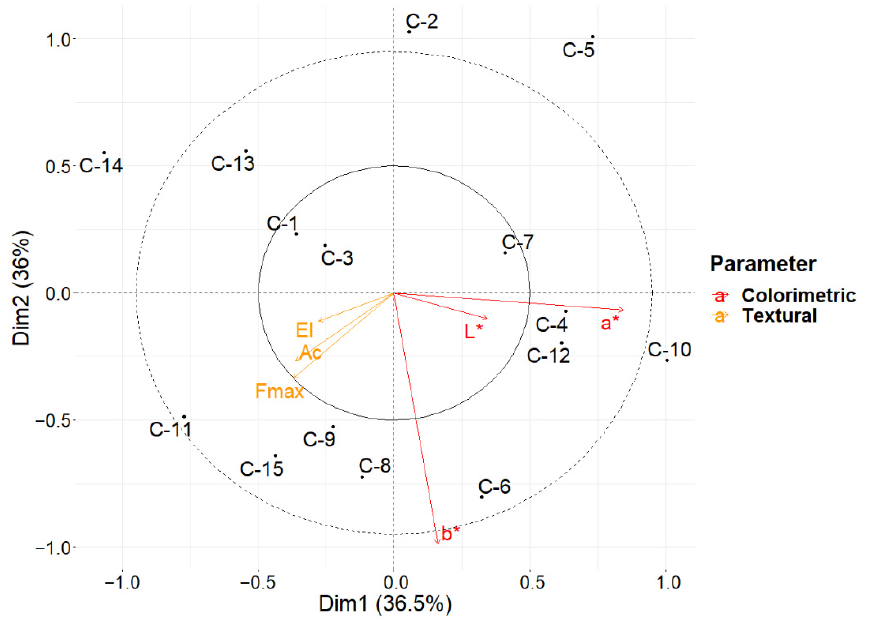
Figure 5. Biplot for ASCA showing the values for the first two principal components for the LMM- ASCA decomposition to the factor “Dairy Factory”. Score values for each level are represented by black dots and labeled from C-1 to C-15 for each dairy factory. Loading values are represented using arrows for each parameter acquired, and colored according to the type of the measurement: “El” stands for elastic modulus; “Ac” for the area under the curve; “Fmax” for maximum force; “L*”, “a*”, and “b*” labels are referred to the coordinates of the lab color spaces.